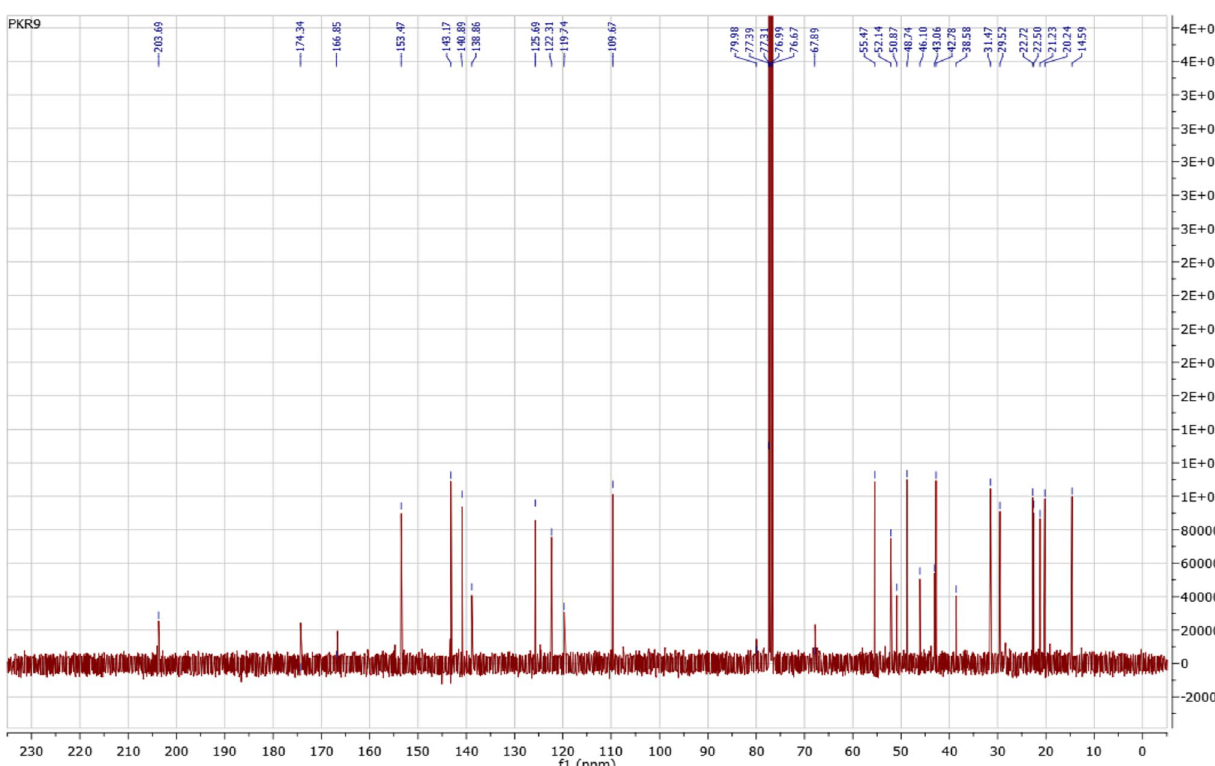
Fig. 6 Experimental data 13 C NMR spectrum of andirobin (CDCl